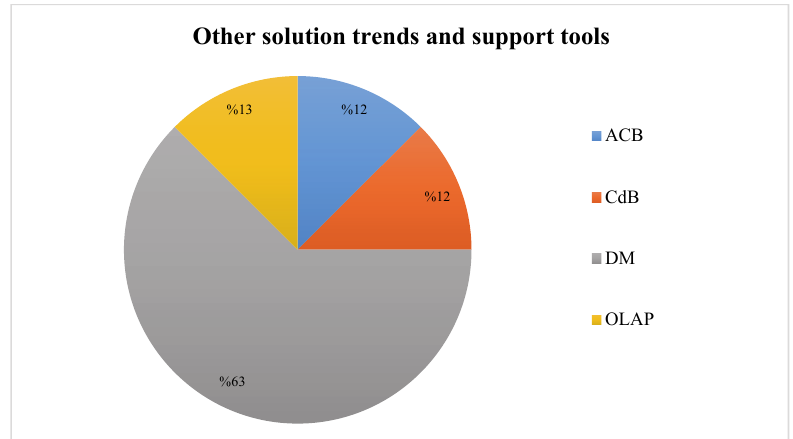
Fig. 12. Distribution of other solution trends and support